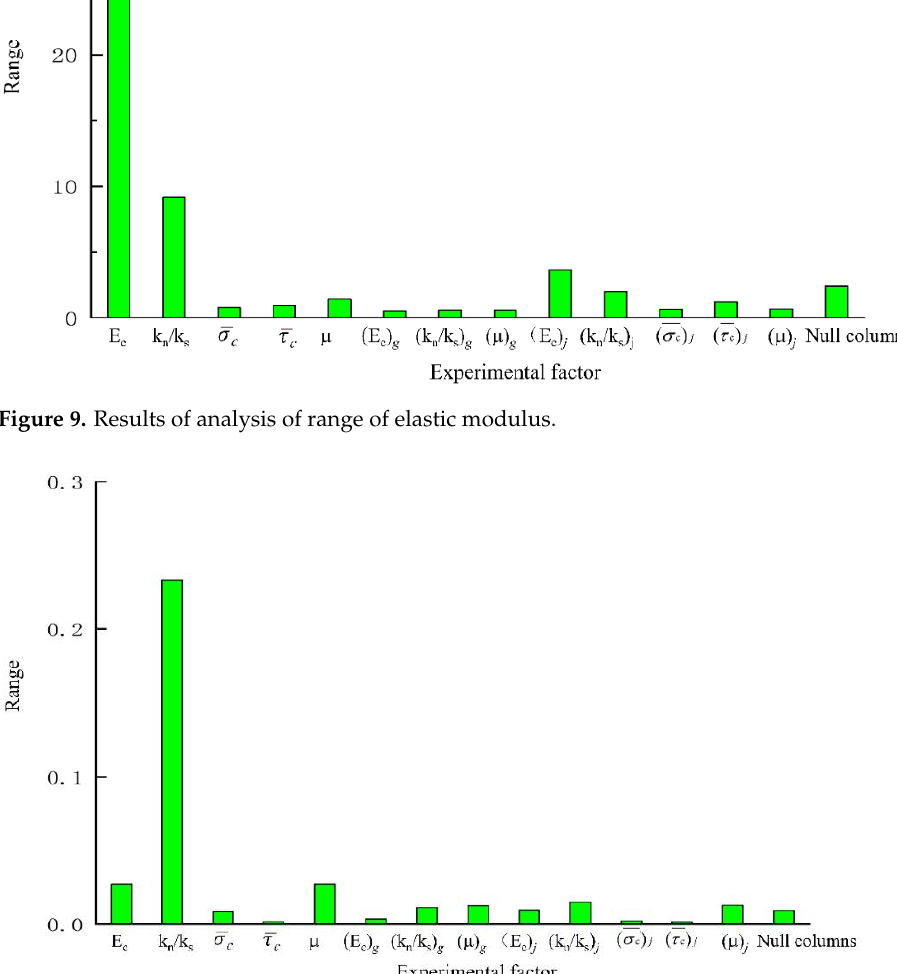
Figure 10. Results of analysis of range of Poisson’s ratio.